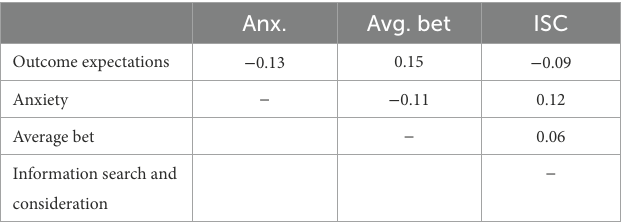
TABLE 2 Correlations among the psychological and behavioral consequences in Study 2.